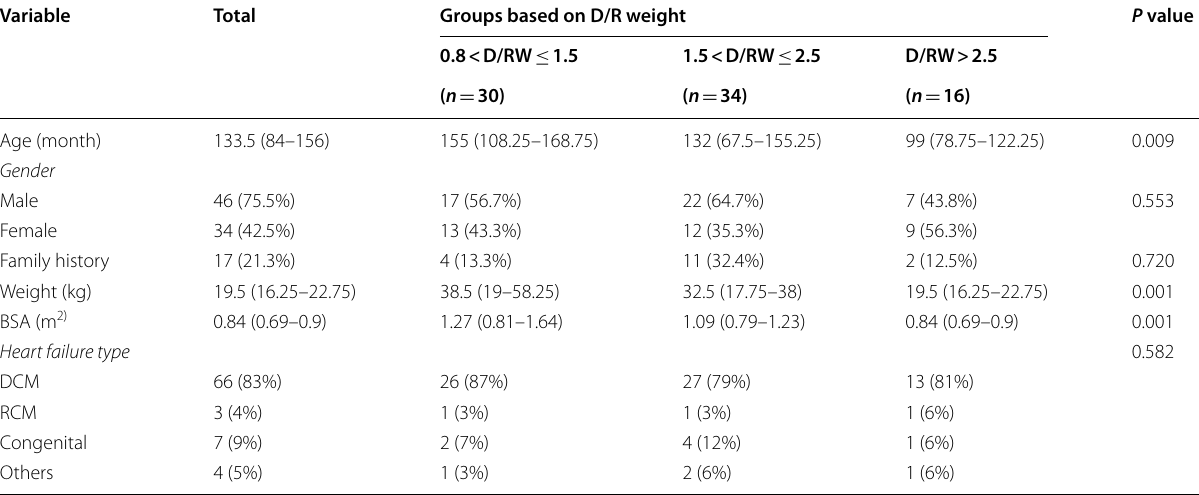
Data presented as median (Q1–Q3) for interval and count (%) for categorical variables. The first quartile (Q1) is equal to the 25th percentile and the third quartile (Q3) is equal to the 75th percentile of the